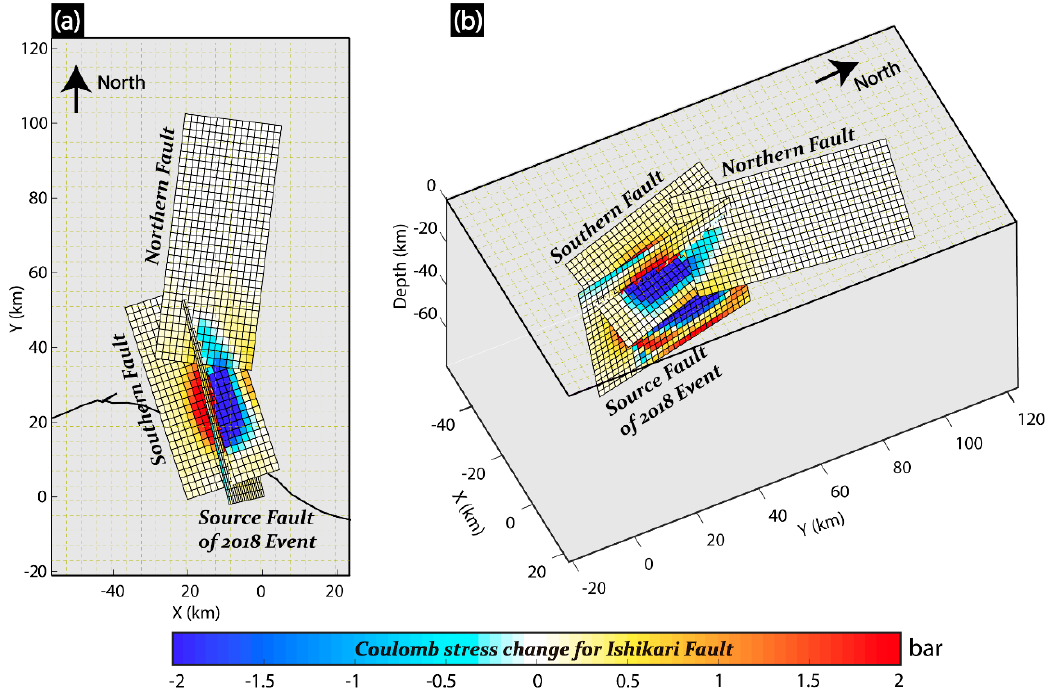
Figure 10. The Coulomb stress change calculated onto the Ishikari fault as viewed form above ( a ) and in 3D from south-east ( b ).